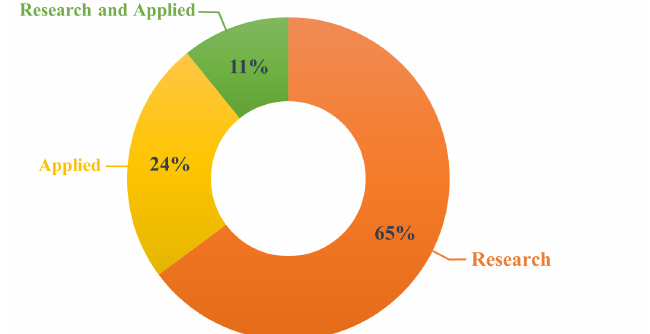
Figure 4. Publication